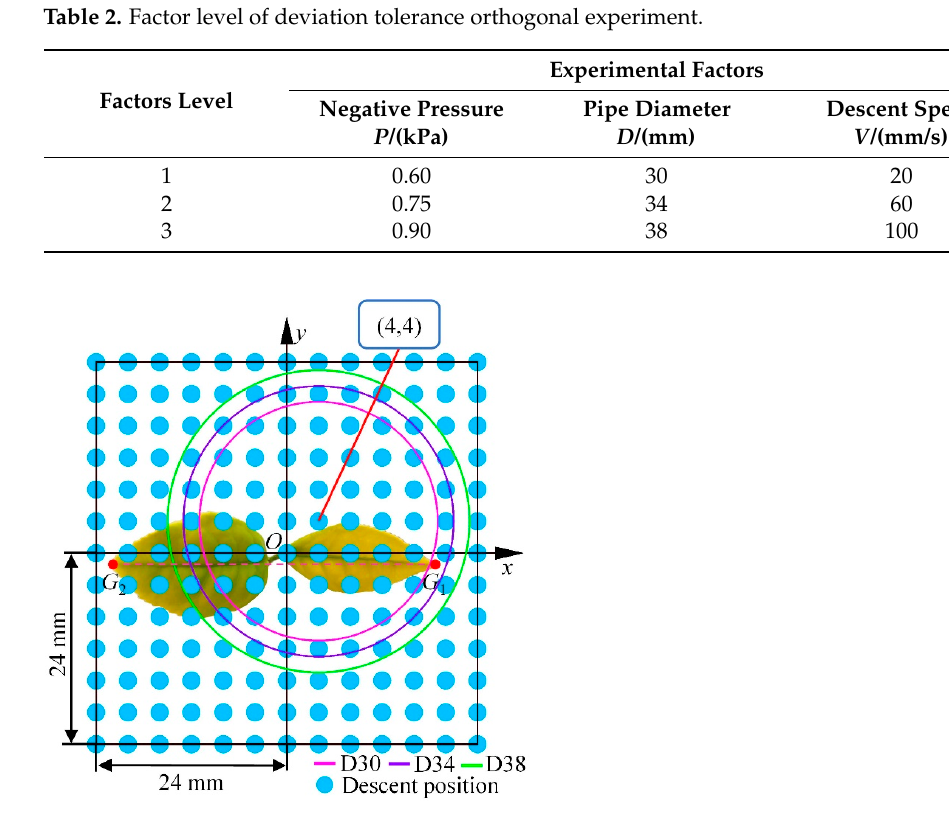
Figure 17. Layout diagram of descent position. Table 2. Factor level of deviation tolerance orthogonal experiment.